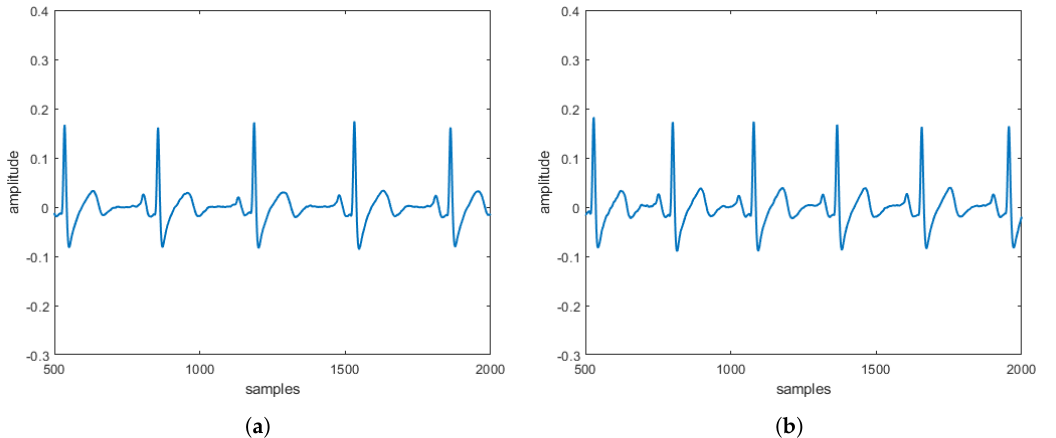
Figure 4. ( a ) ECG reconstruction by system (16) (case (c)). ( b ) Typical ECG obtained from a patient not suffering from any cardiac